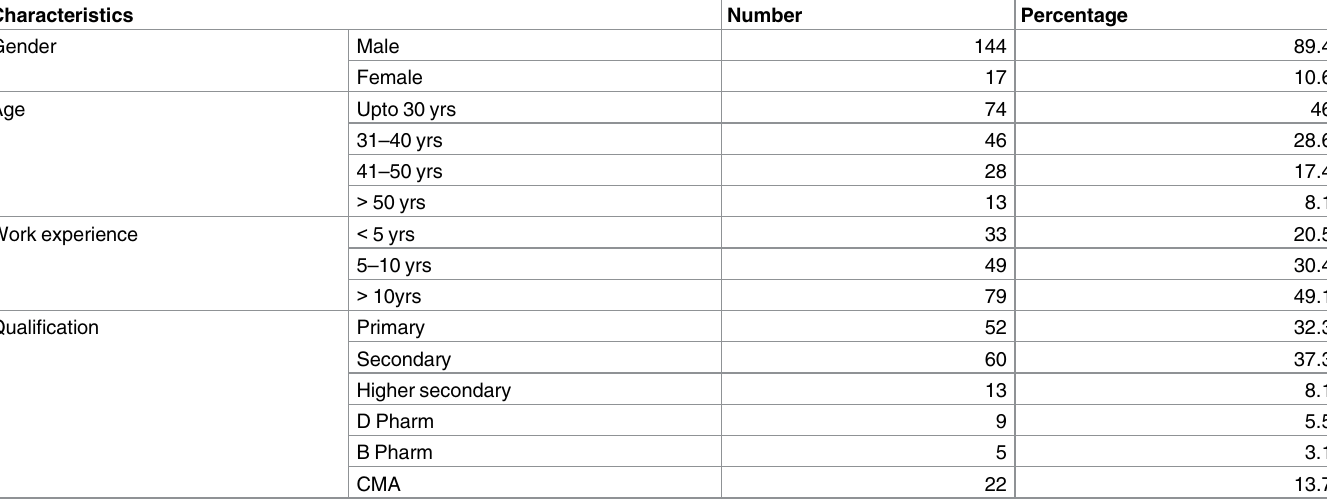
Table 1. Demographic characteristics of pharmacystaff (n = 161).